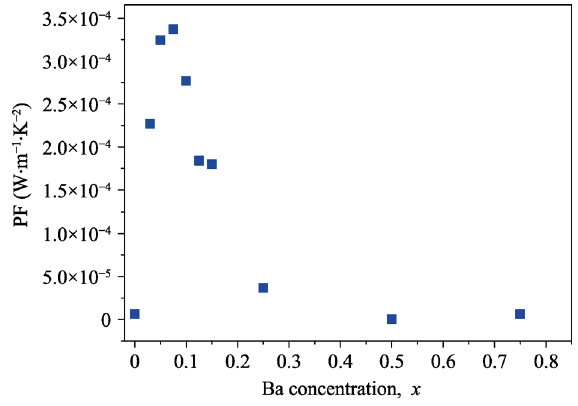
Fig. 6 PF for La 1 − x Ba x CoO 3 with 0 ≤ x ≤ 0.75 at 330 K. electrical